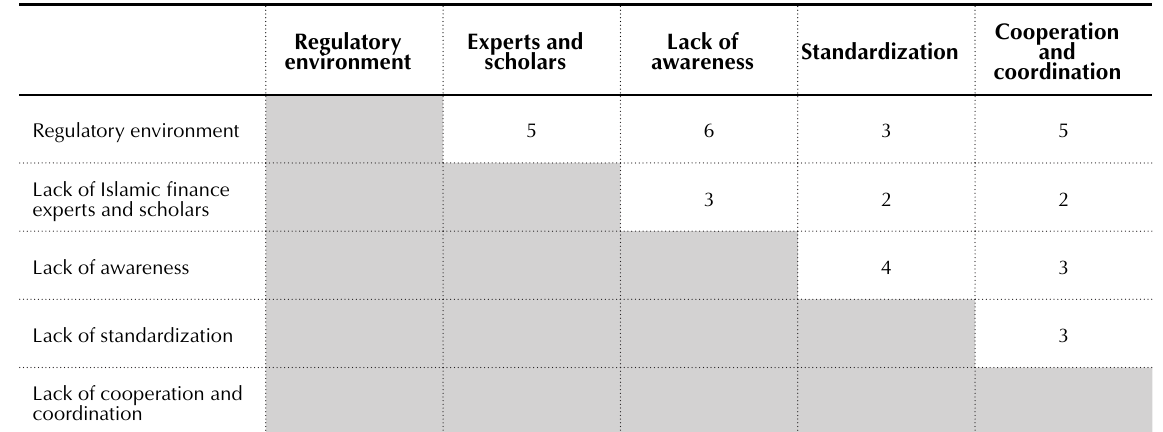
Table 2. Pairwise comparison and consistency